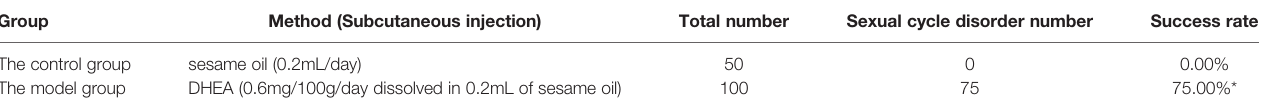
The Expression of Mitochondrial Functional Genes NDUFB8 and ATP5j in PCOS Model Rat Ovarian GCs Were Signi fi cantly Reduced Real-time PCR results showed that the mRNA expressions of NDUFB8 and ATP5j genes in the PCOS model group rats were signi fi cantly decreased compared with the control group rats ( P <